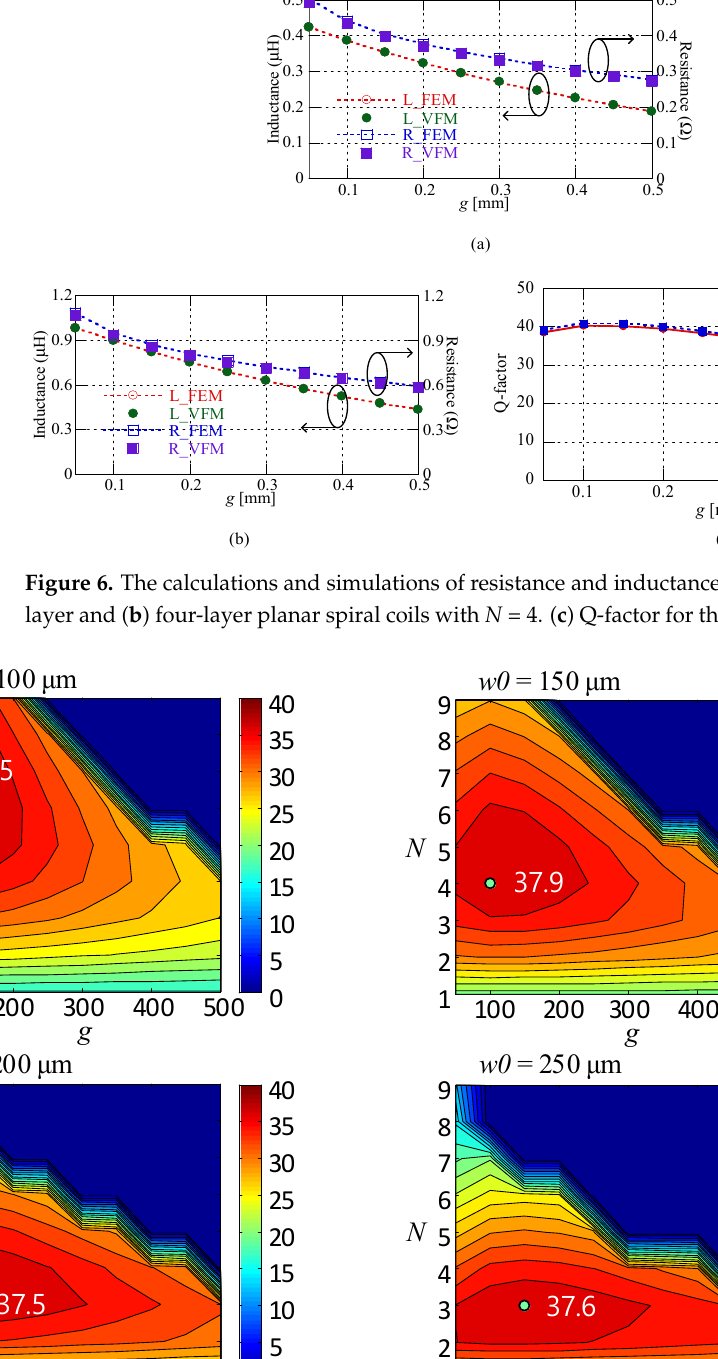
(c) Figure 5. The calculations and simulations of resistance (R) and inductance (L) according to N for ( a ) double-layer and ( b ) four-layer planar spiral coils with g = 0.15 mm. ( c ) Q-factor for the double- layer planar spiral coil. In Figure 6, the calculations of resistance and inductance according to the gap g be- tween two neighboring patterns are compared with simulated values for double-layer and four-layer planar spiral coils for N = 4. As shown, the calculation is in good agreement